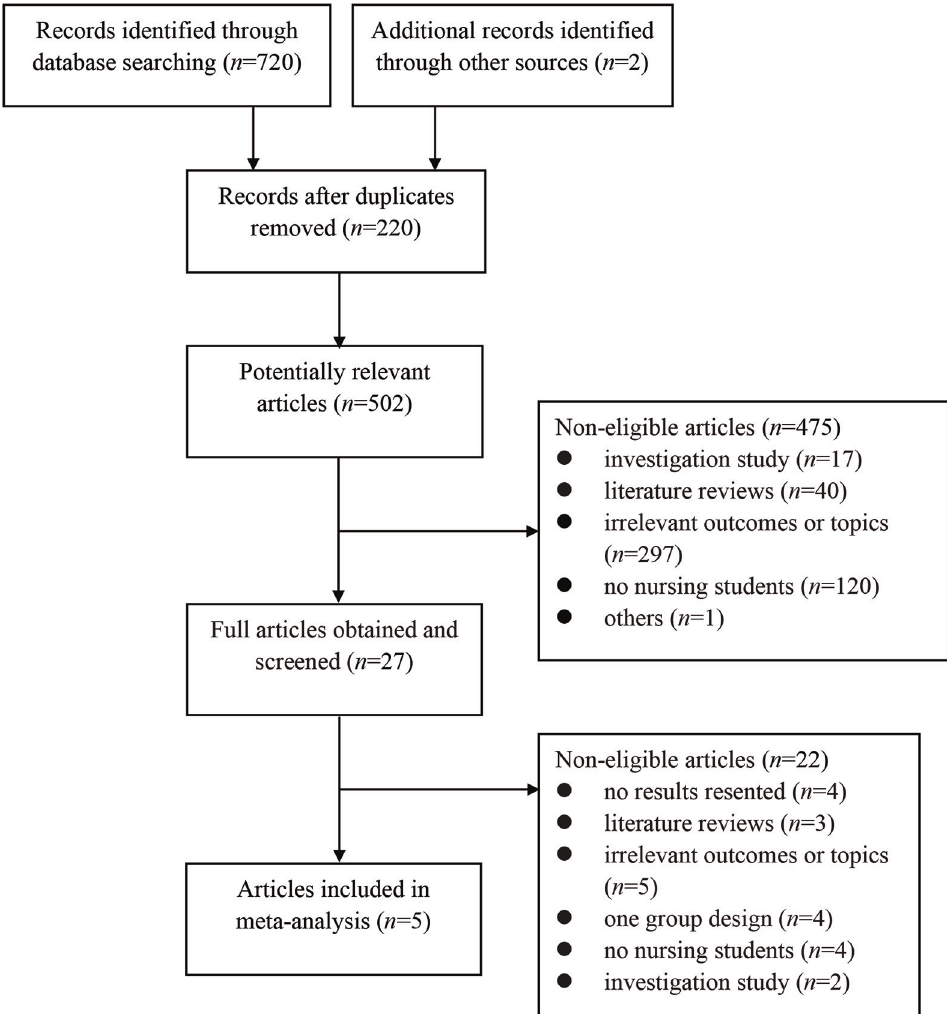
Figure 1. Flow diagram of inclusion and exclusion